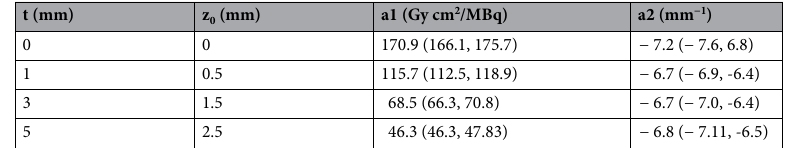
Table 2. Coefficients of the best fit curves, with 95% confidence interval (round brackets), to the normalized dose profile as a function of the z distance and the t